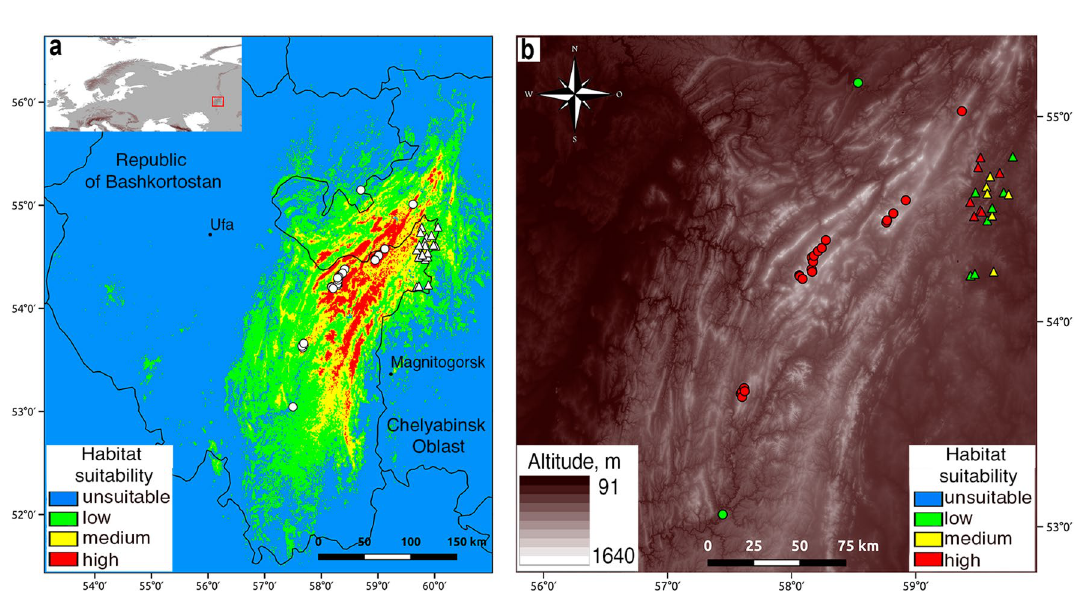
Figure 2. ( a ) The current potential range and locations of Patrinia sibirica in the Southern Urals; the location of the study area is shown in the upper left corner; ( b ) Elevation map and habitat suitability in the known locations of the species. Mountain forest locations are marked with circles, mountain forest-steppe locations are marked with triangles. The maps were created using QGIS (v.3.14; www. qgis. org) and GIMP (v.2.10.24; www. gimp.